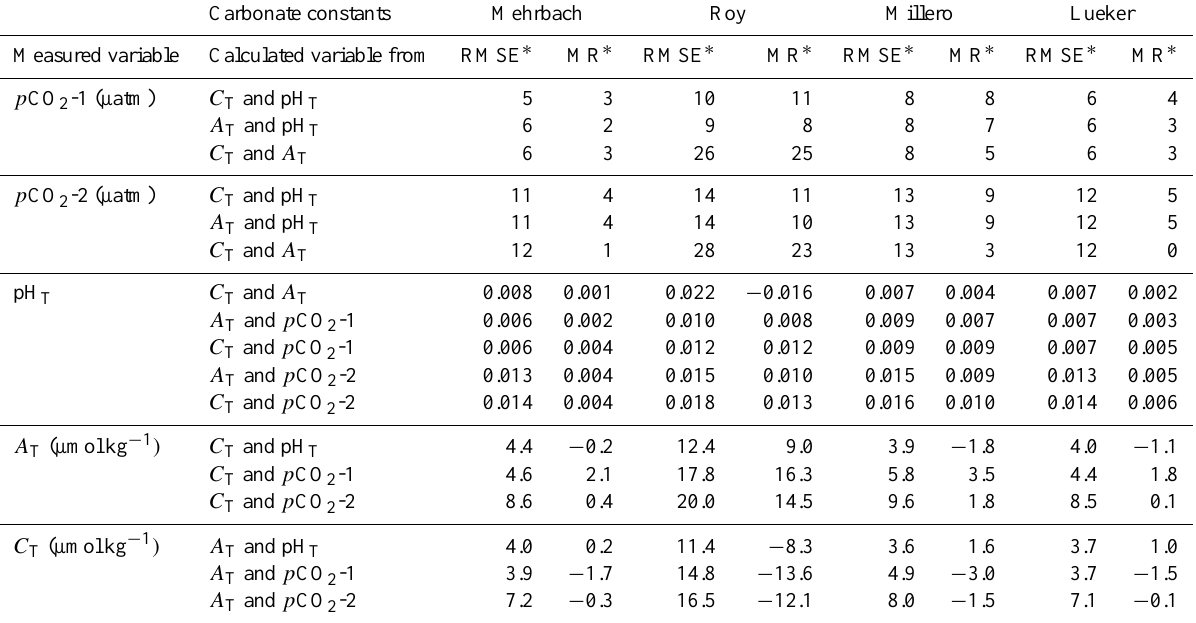
Table 3. Comparison of directly measured pH T , partial pressure of CO 2 ( p CO 2 ) , dissolved inorganic carbon ( C T ) and total alkalinity ( A T ) to values calculated using different carbonate constants. RMSE is root mean square error and MR is mean of the residuals. The two different carbonate constants are from Roy et al. (1993), Millero et al. (2006), and Mehrbach et al. (1973), refitted by Dickson and Millero (1987) and Lueker et al. (2000). The ratio of total boron to salinity is from Uppström